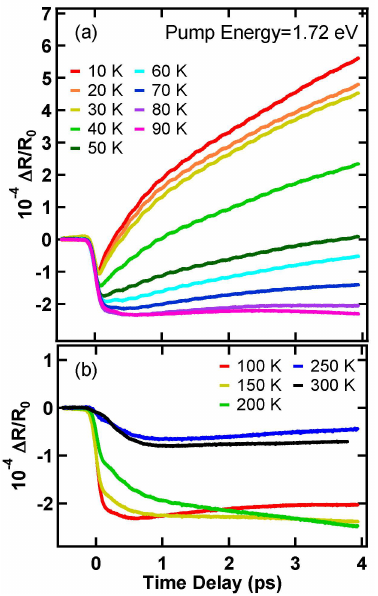
Figure 7. ( a ) Temperature dependence of the ∆ R / R 0 signal in the YMnO 3 thin film at the pump photon energy of 1.72 eV with 20 mW in the temperature ranges from 10 to 90 K ( a ) and from 100 to 300 K ( b ).